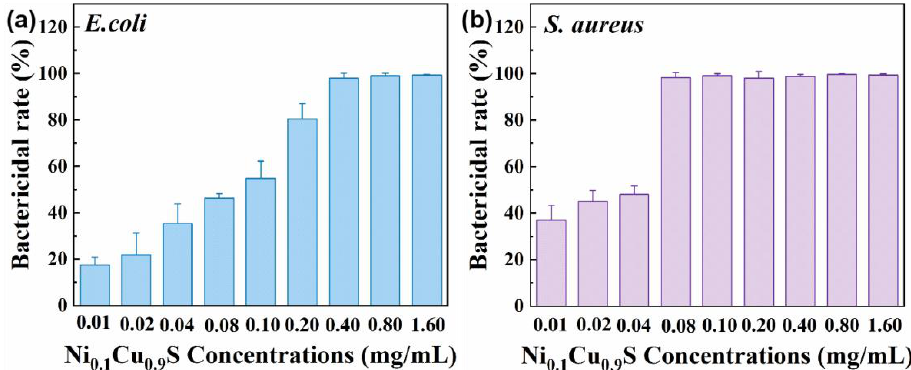
Figure 7. Bactericidal rate of reaction systems against ( a ) Gram-negative E. coli and ( b ) Gram-positive S. aureus , respectively, treated with different concentrations of Ni 0.1 Cu 0.9 S nanoflower.